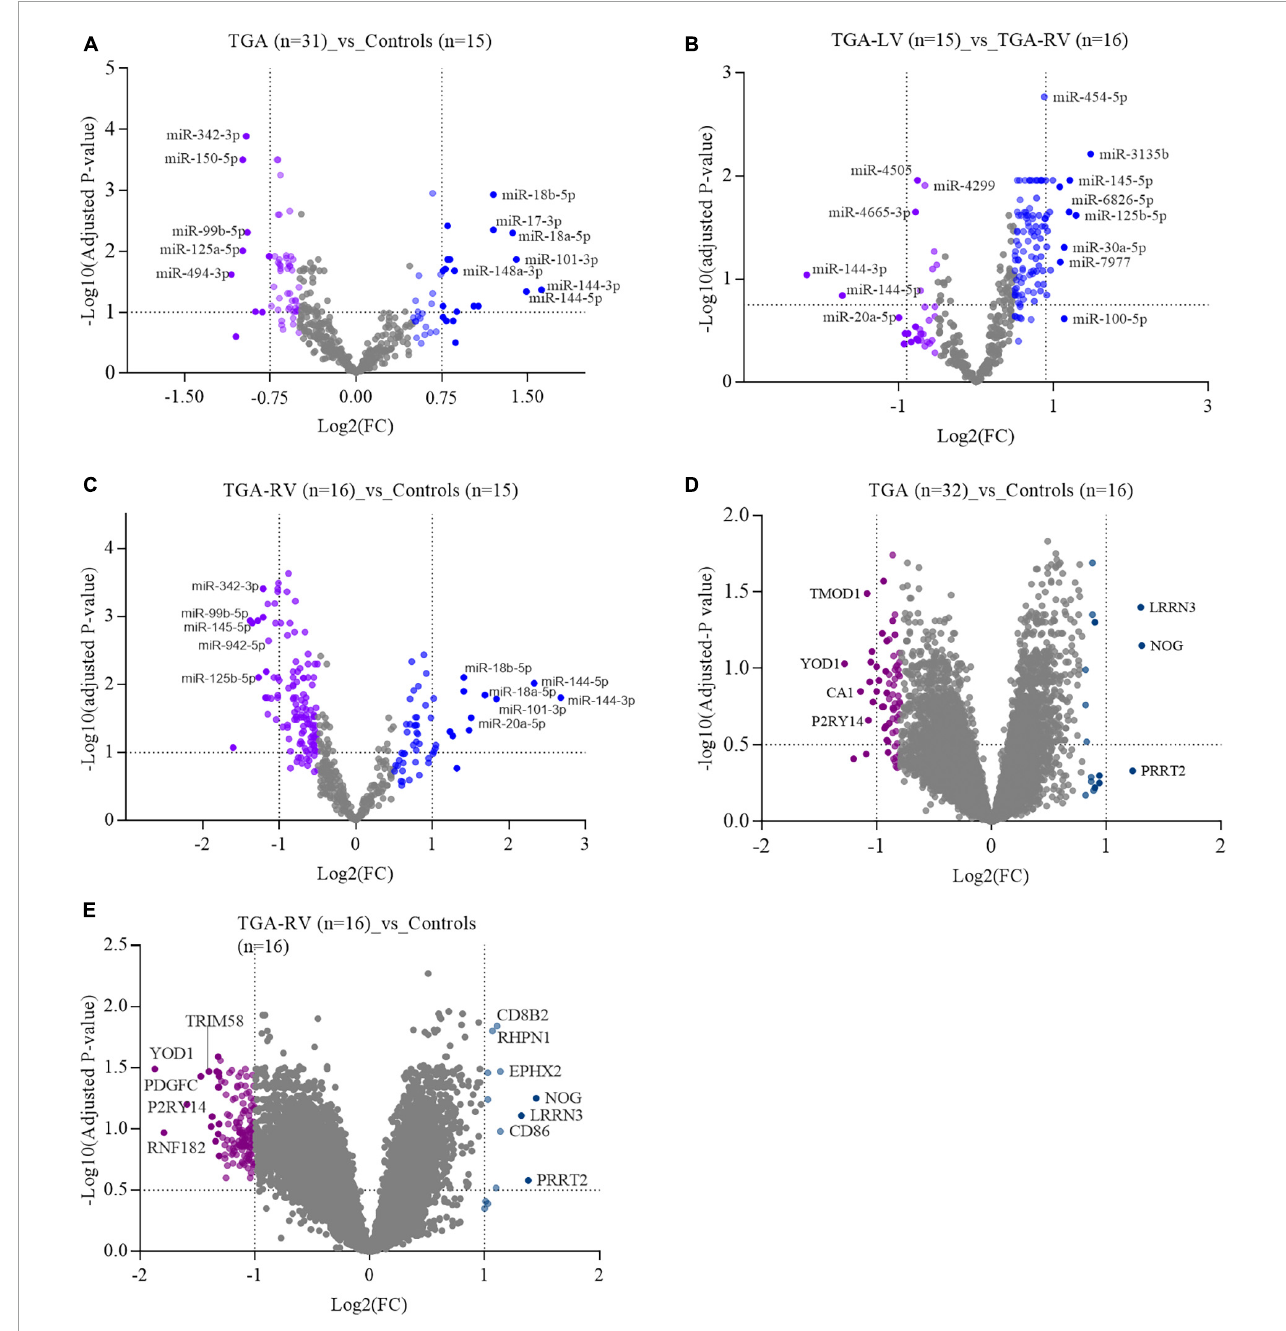
FIGURE1 A volcano plot showing the log2 fold change of most significantly expressed miRNAs and miRNAs in blood samples of patients with TGA (TGA-RV and TGA-LV) compared to matched controls, as determined by microarray analysis.